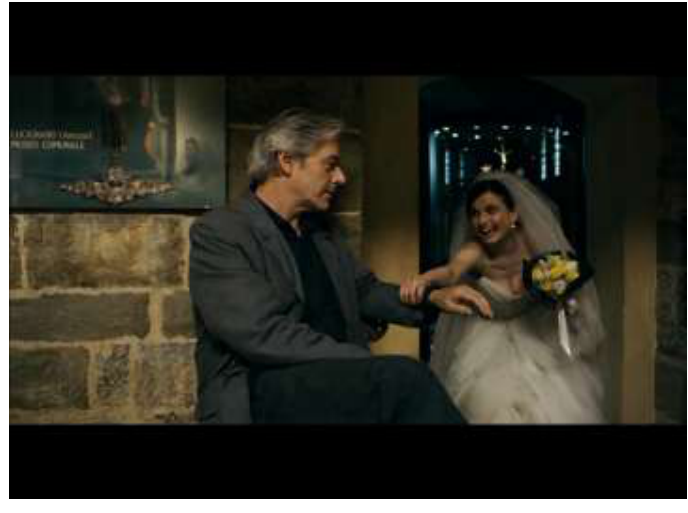
Figure 4: Here, James is once again visually blocked in by what he finds threatening—in this case, the institution of marriage, symbolized by the bride reaching out to pull him into the next room in order to take a photograph and by the mini-reflection of yet another bride in the framed poster just over his right